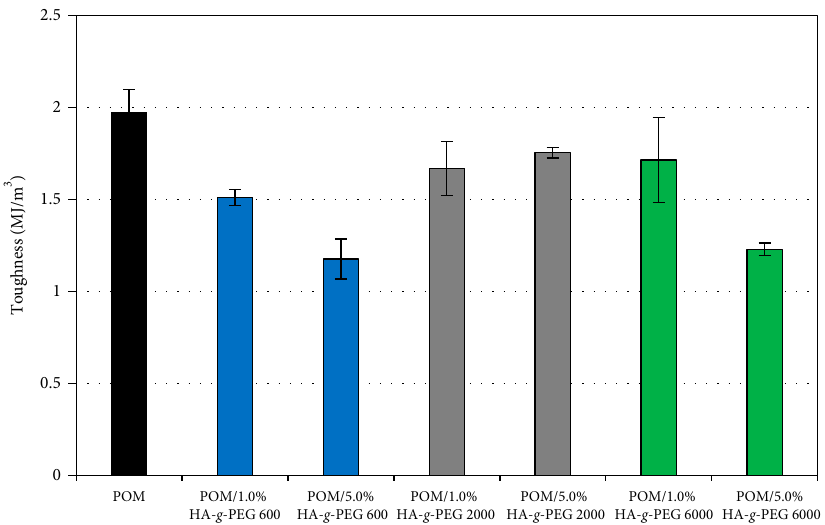
Figure 8: Toughness of POM/HA- g -PEG composites.